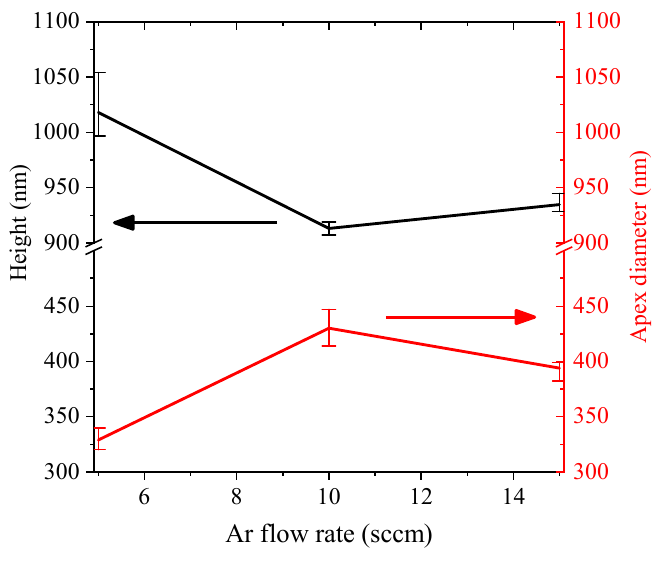
Figure 8. Submicron lens height (black line, left axes) and apex diameter (red line, right axes) versus Ar gas flow rate.